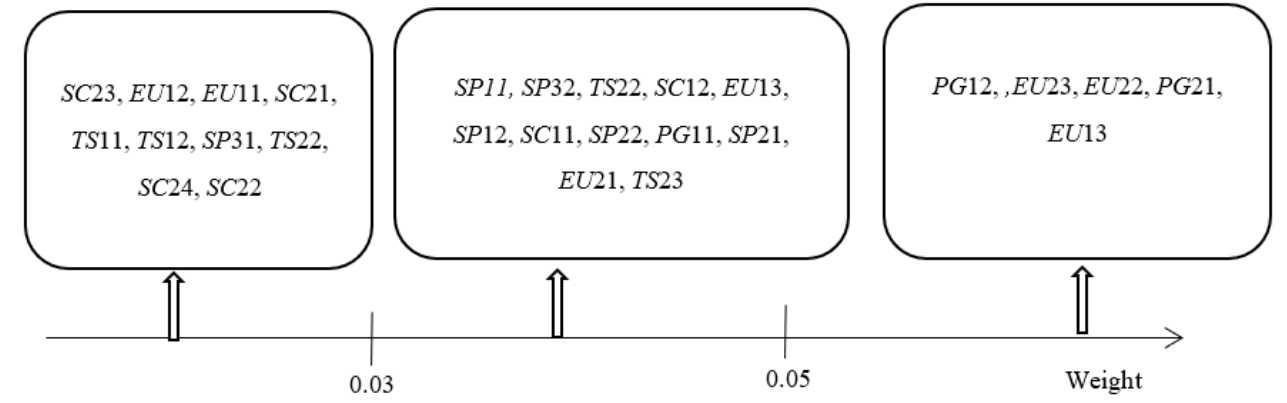
Figure 2. Weight Level Diagram of Evaluation Indexes for Low Carbon Development of the Power Industry.